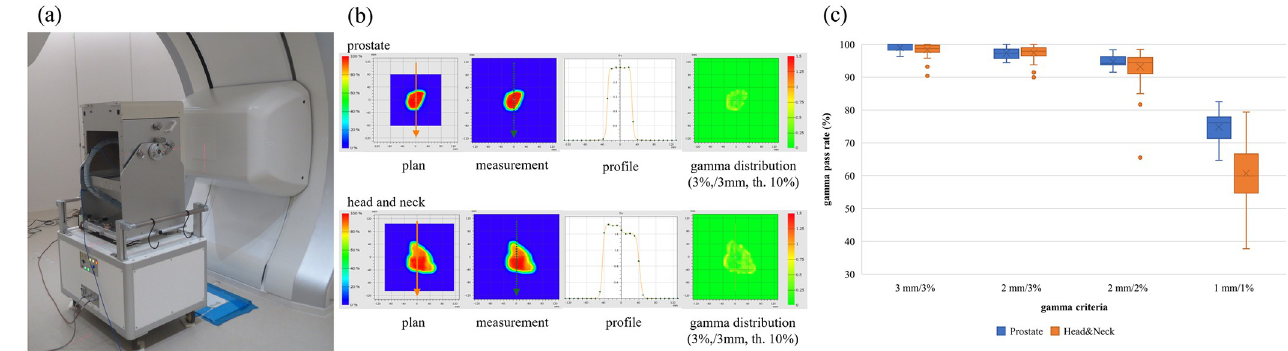
Fig 11. PSQA performed in our institute. (a) Measurement device combined with a 2D ionization chamber array and an accordion-type water phantom. (b) Typical results for PSQA. The upper and lower panels show the PC and HNC cases, respectively. The arrows on the dose distribution indicate the dose profile’s direction. (c) The gamma passing rate in the clinical